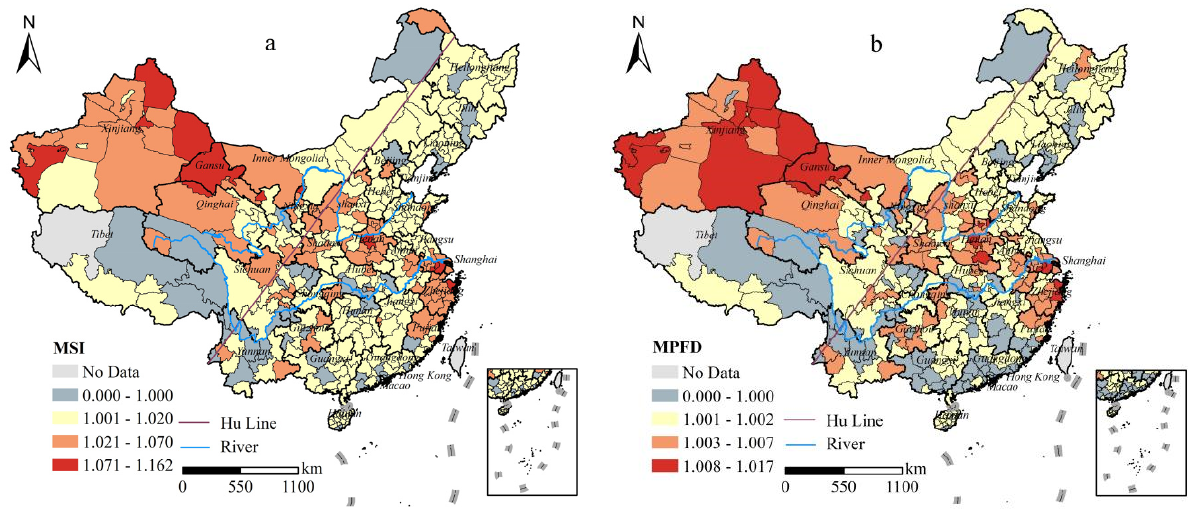
Figure 3. Changing rural settlement landscape shape metrics in China 1995–2015. ( a ) the mean shape index (MSI) of rural settlements at the start and end of the study period to identify changes; ( b ) the mean patch fractal dimension (MPFD) of rural settlements at the start and end of the study period to identify changes.